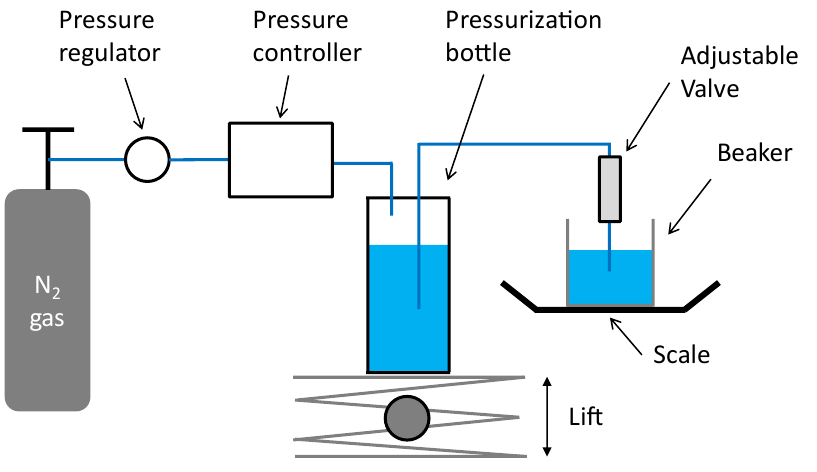
Figure 9. Schematic representation of the test setup.